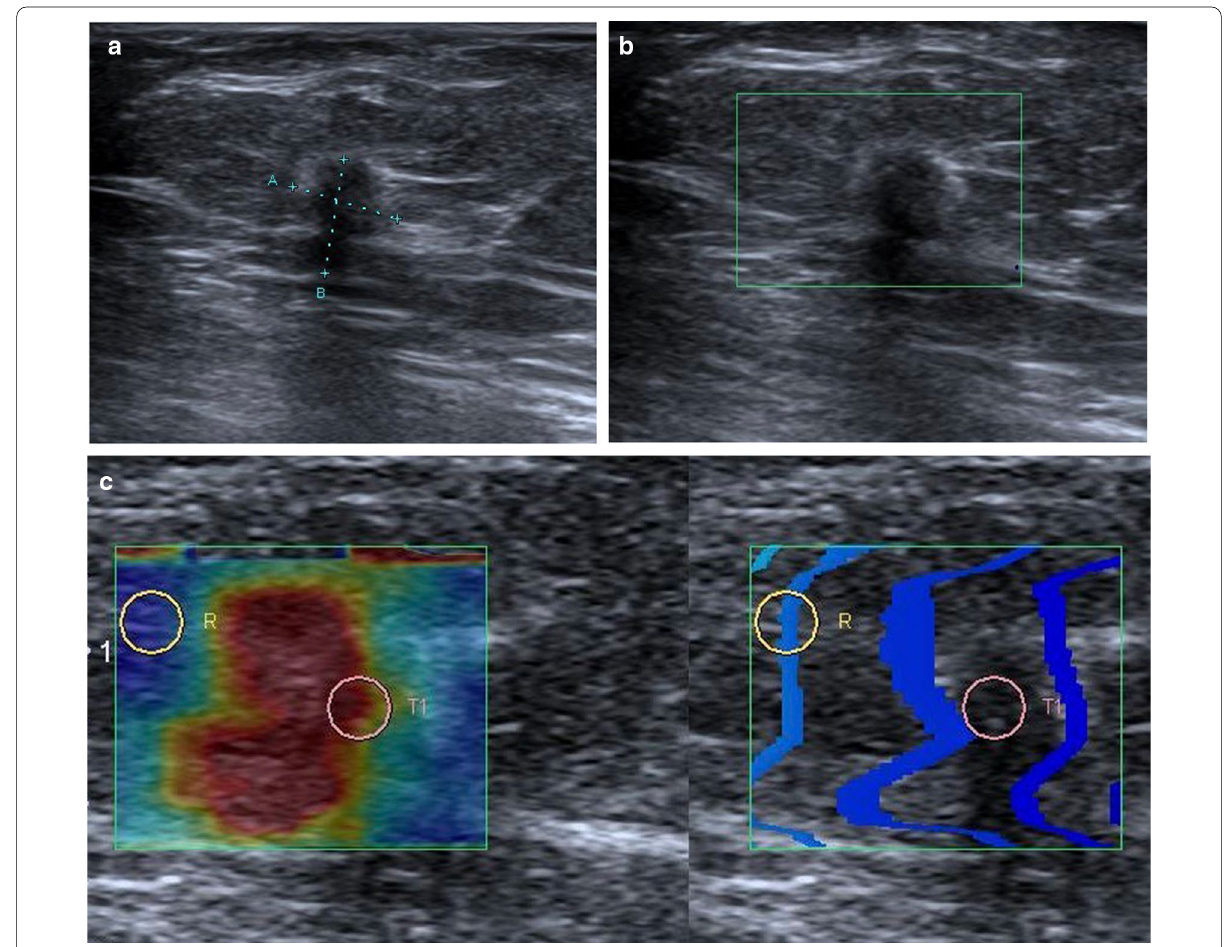
Fig. 2 Sonographic findings. a The vertically oriented hypoechoic lesion, irregular in shape with indistinct margins. b No vascular coding in color Doppler image. c High elasticity features with shear wave